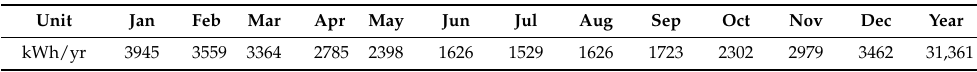
Table 4. The monthly thermal energy demand at the campus